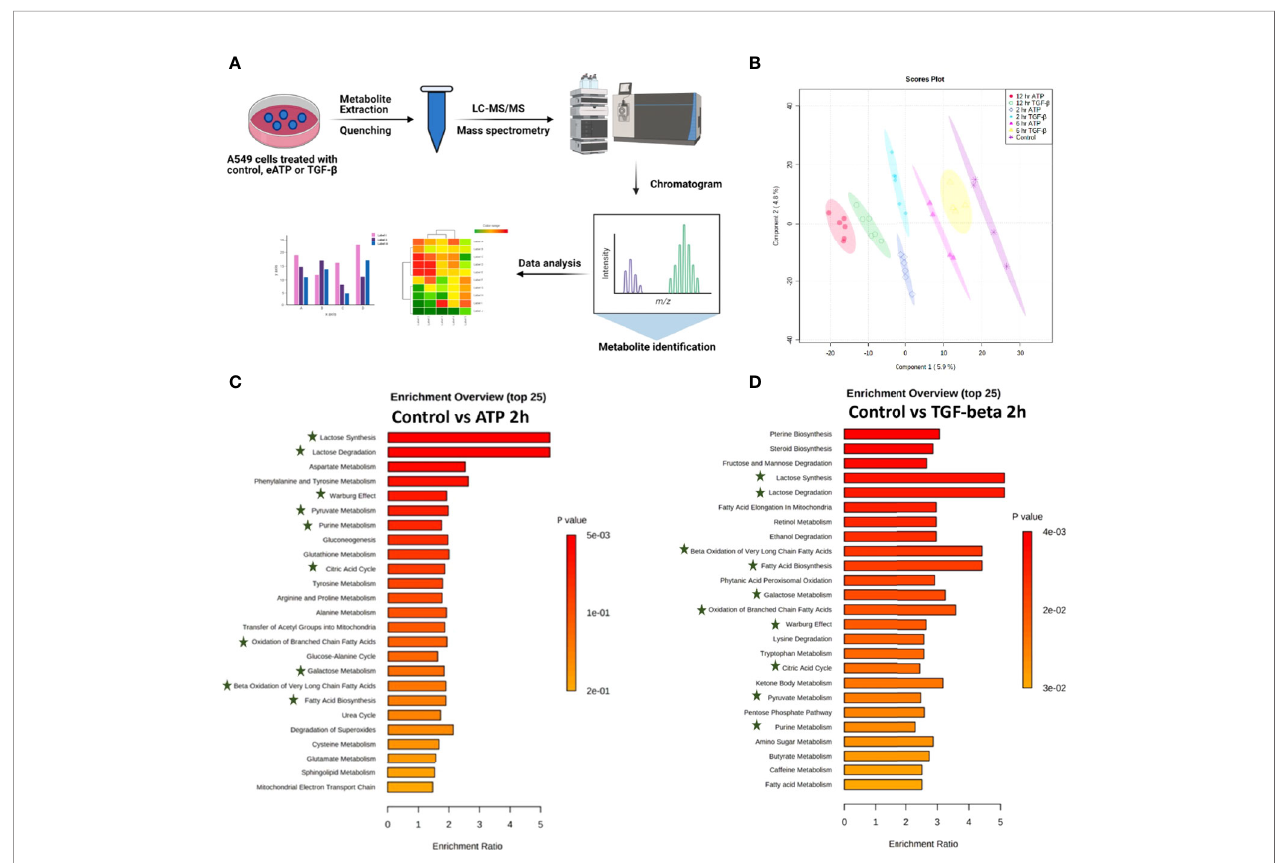
FIGURE 2 | Metabolomics analysis of metabolic changes induced by Eatp. A549 cells were treated with either ATP or TGF- b for 0 (control), 2, 6 and 12 hours. Specially prepared cell lysates were subjected to a metabolomics analysis as described in Materials and Methods. The metabolomics data were presented in different ways to show their EMT-related features, similarities between ATP and TGF- b , and differences from the control. (A) Schematic presentation of the design of the metabolomics study. (B) PLS-DA plot for eATP or TGF- b treated samples at different treatment times as compared to the untreated control. (C, D) Metabolic pathway enrichment analysis of ATP treatment at 2 hr (C) , and enrichment by TGF- b at 2 hr (D) . Shared metabolic pathways enriched in both conditions are highlighted with